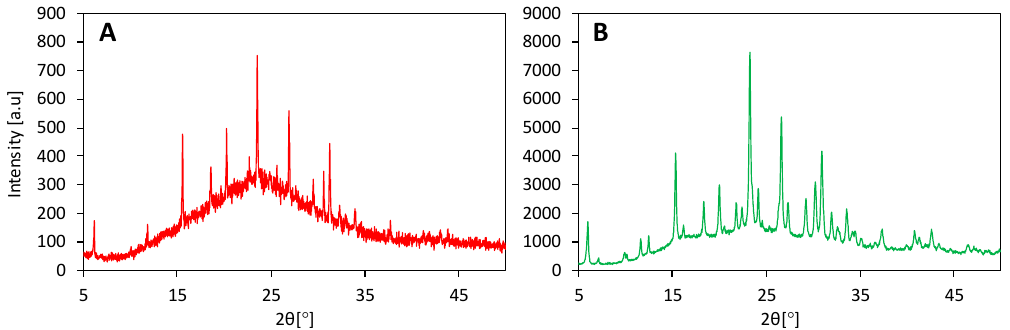
Figure 3. Diffractogram of ( A ) Zeolite Y beads prepared in our lab in the absence of organic SDA and ( B ) Zeolite Y beads prepared in our lab in the presence of TMA + .